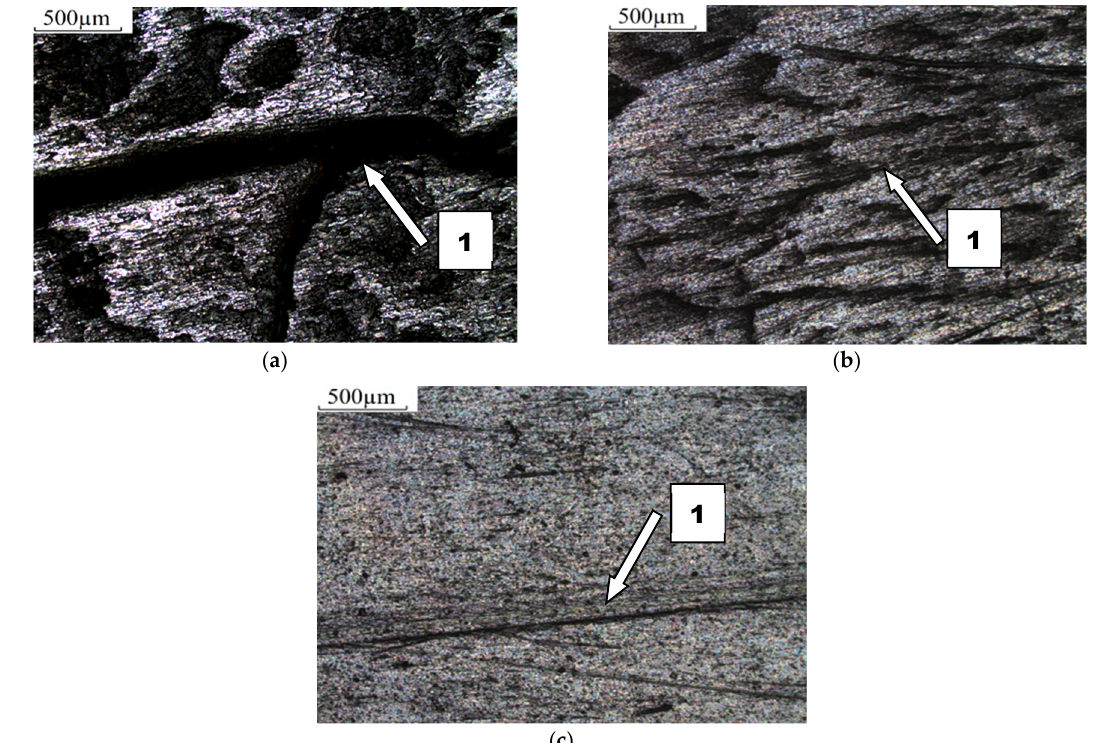
Figure 15. Condition of worn surface of B27 steel in diverse soil conditions: ( a ) light soil, (1) micro-cutting; ( b ) medium soil, (1) furrowing; ( c ) heavy soil, (1) furrowing.